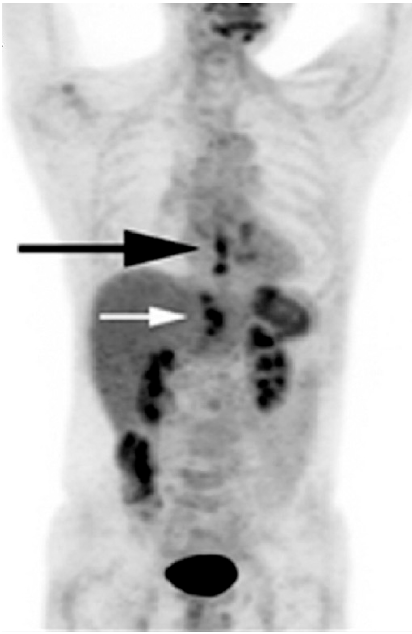
Figure 3. Hepatic radiation injury in a patient who underwent radiotherapy for distal esophageal cancer. The coronal maximum projection image (FDG PET image) shows residual esophageal tumor hypermetabolism (SUVmax = 3.4) (black arrow) and hypermetabolic areas (SUVmax = 3.5) in liver segments I, II, and III (white arrow). (Used with permission from [61]). SUV, standardized uptake value.